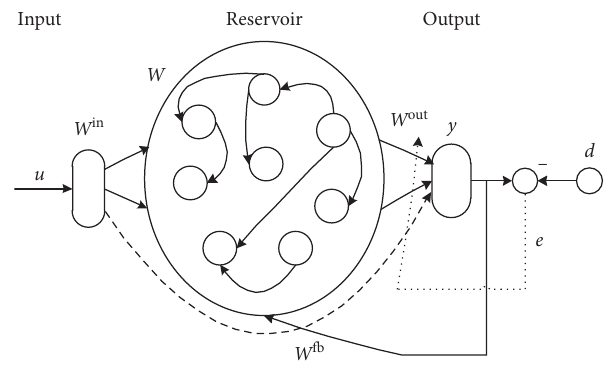
Figure 1: Structure of